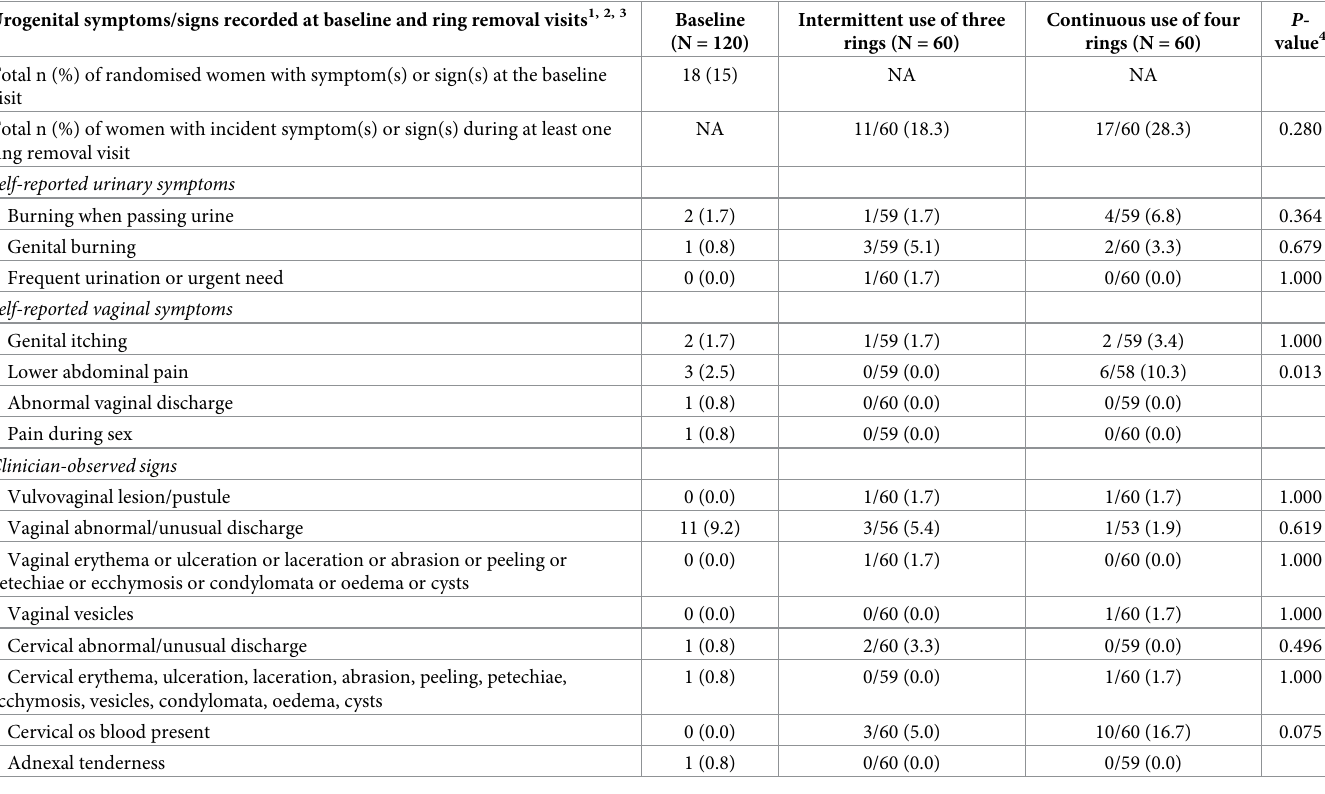
Table 2. Urogenital self-reported symptoms and clinician-observed signs (not associated with a laboratory-confirmed infection at the same visit) by randomisation group. Urogenital symptoms/signs recorded at baseline and ring removal visits 1, 2,